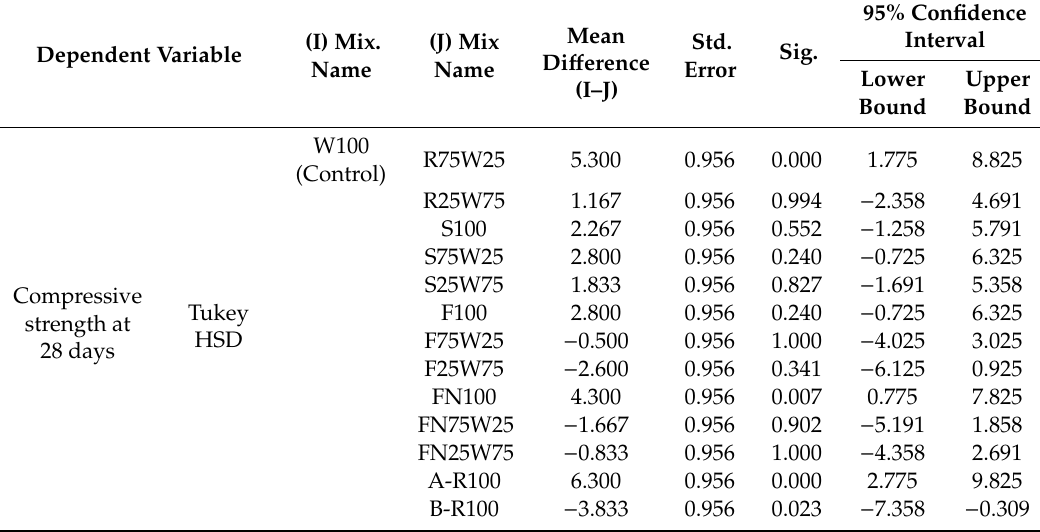
Table 10. Statistical significance di ff erences of concrete compressive strength at 90 days curing time was evaluated by general liner model multivariate—Tukey multiple comparisons test at p ≤